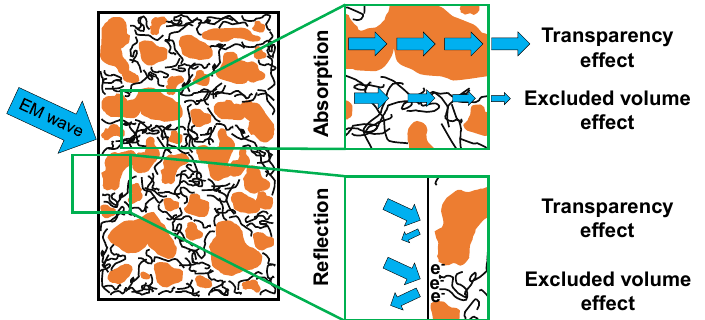
Scheme 2. The schematic of excluded volume and transparency effects of the waste material on EMI shielding performance (absorption and reflection) of PS/Waste/CNT nanocomposite. The white and orange phases represent PS and the waste material, respectively.